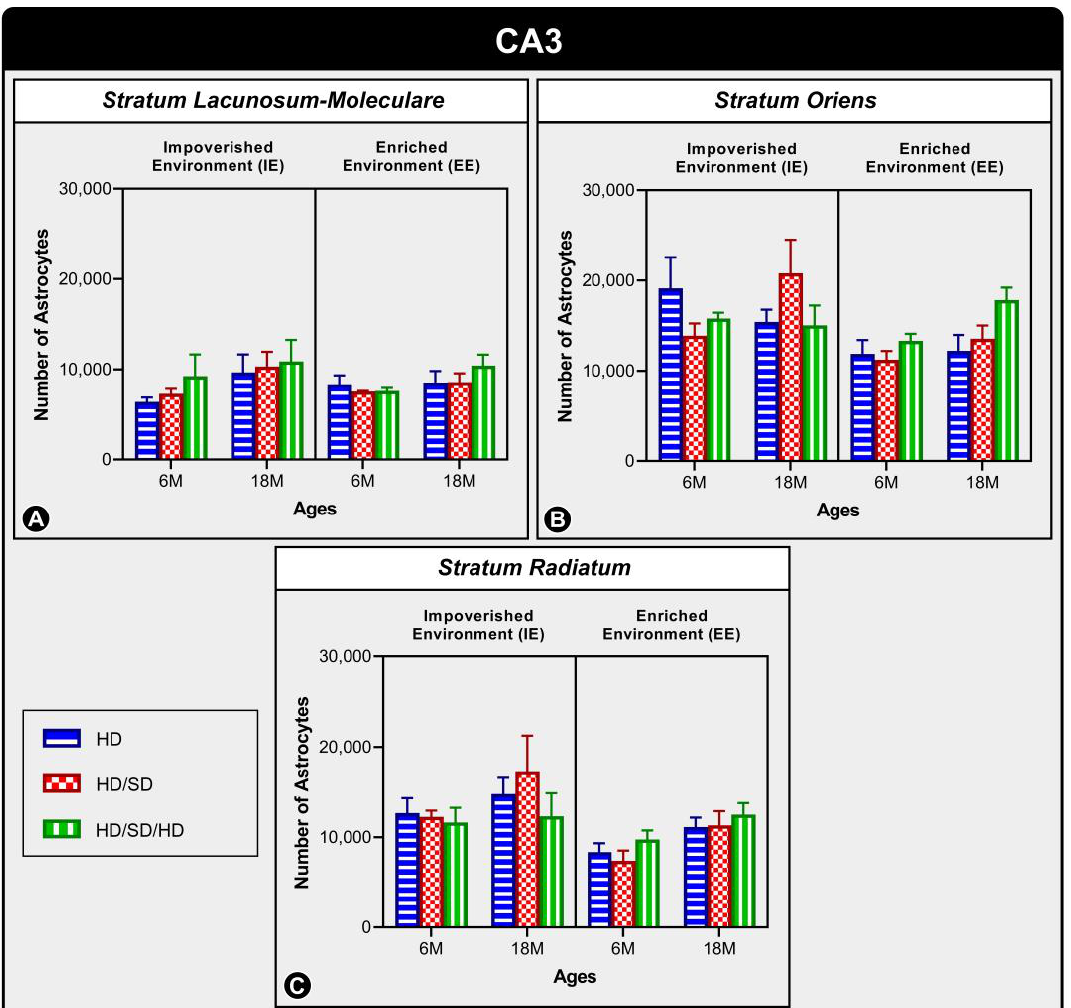
Figure 2. Graphical representation of astrocyte numerical estimation in CA3’s three layers: Stratum Lacunosum-Moleculare ( A ), Stratum Oriens ( B ), and Stratum Radiatum ( C ) under the effects of environment, age, and diet. The graph shows the quantitative results of astrocytes from these layers in the 6-month-old age group (6M) and 18-month-old age group (18M) reared in standard, impoverished environment (IE), and enriched environments (EE) and submitted to one of three types of diet: HD, hard diet (in blue) = pelleted ration; HD/SD, hard diet/soft diet (in red) = pelleted and mashed chow; and HD/SD/HD, hard diet/soft diet/hard diet (in green) = pellet/powdered/pelleted feed. In this graph, no statistically significant differences were found between the investigated variables.